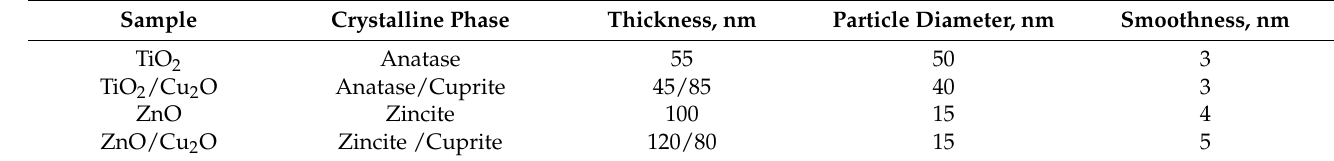
Table 1. Characterization of the